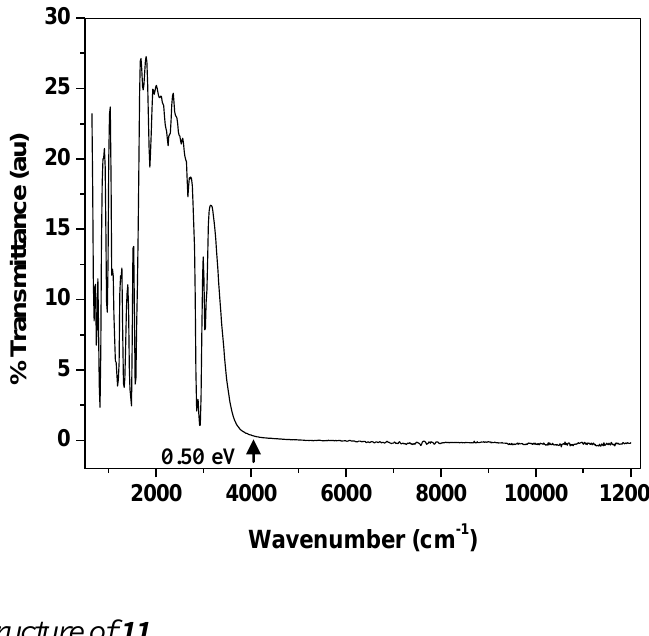
Figure 9. Single crystal IR and UV-vis transmission spectra of radical 11